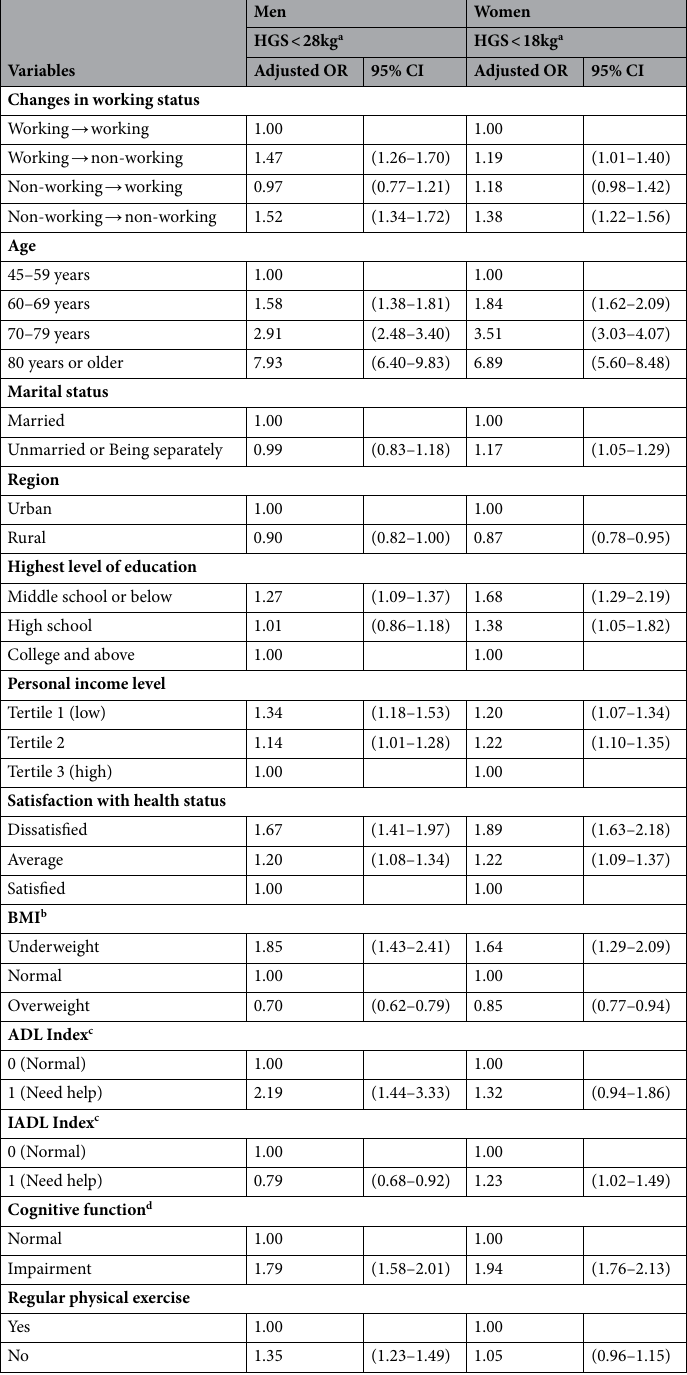
Table 2. Results of GEE analysis of factors associated with low hand-grip strength. GEE generalized estimating equation, OR odds ratio, CI confidence interval, HGS hand-grip strength, BMI Body Mass Index, ADL Activities of Daily Living, IADL Instrumental Activities of Daily Living. a Criteria defined by AWGS (Asian Working Group for Sarcopenia) in 2019. b Underweight (BMI of less than 18.5 kg/m 2 ), Normal (BMI of 18.5–24.9 kg/m 2 ), Overweight (BMI of 25 kg/m 2 or over). c 0 point (If they do not need any help), 1 point (If they need some help, or if they need help altogether). d Normal (MMSE score of 24 points or more), Impairment (MMSE score of 23 points or